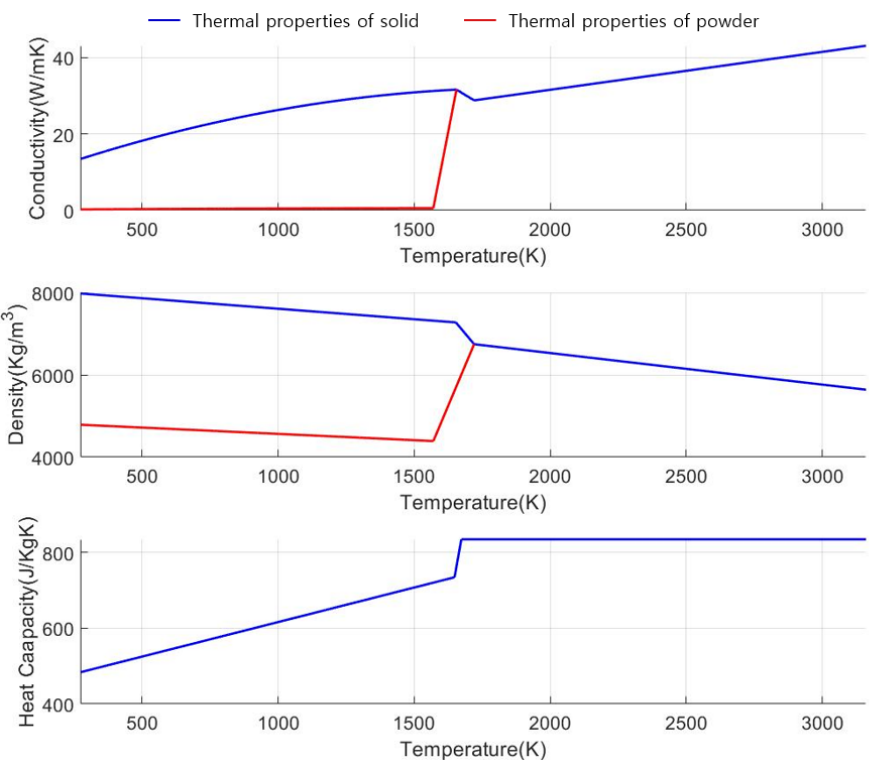
Figure 3. Thermal properties of AISI 316L solid and powder.